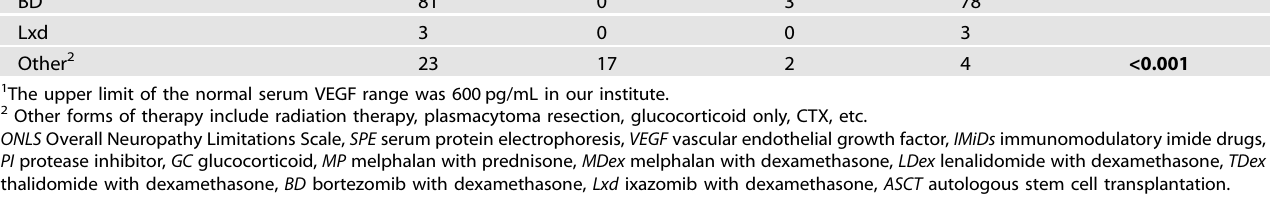
cardiopulmonary failure ( n = 13), disease progression not other-